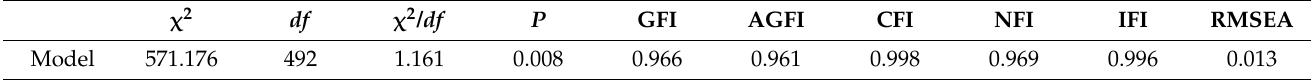
Table 5. Mediated effect model fit indices for physical activity, self-efficacy, and mental